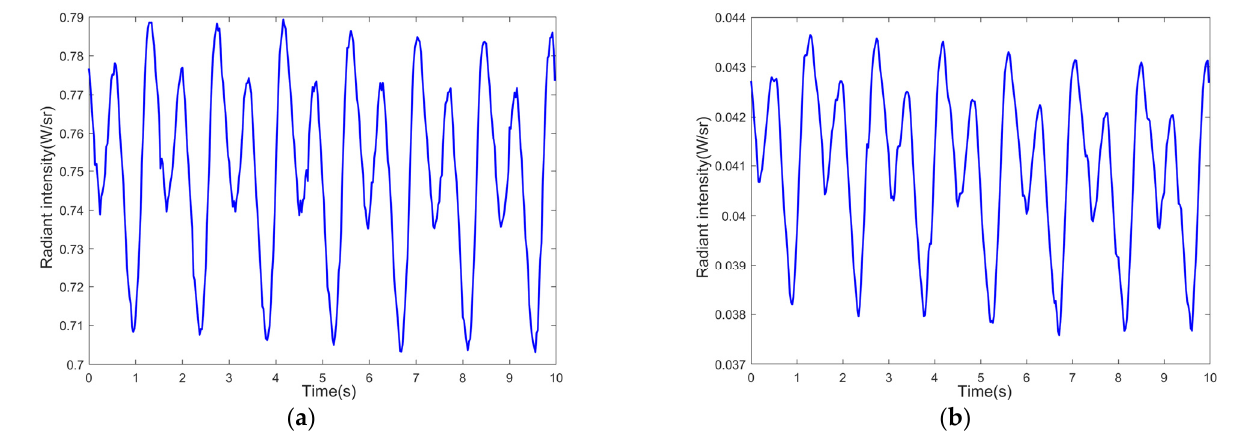
Figure 17. Radiation intensity extracting from multi-frame images; ( a ) 8–11.7 µm; ( b ) 3–5 µm.